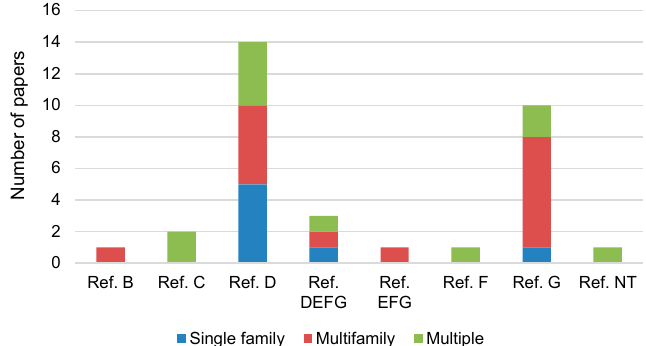
Figure 8. Letters of reference used to estimate the price premium (graph elaborated from 20 papers).